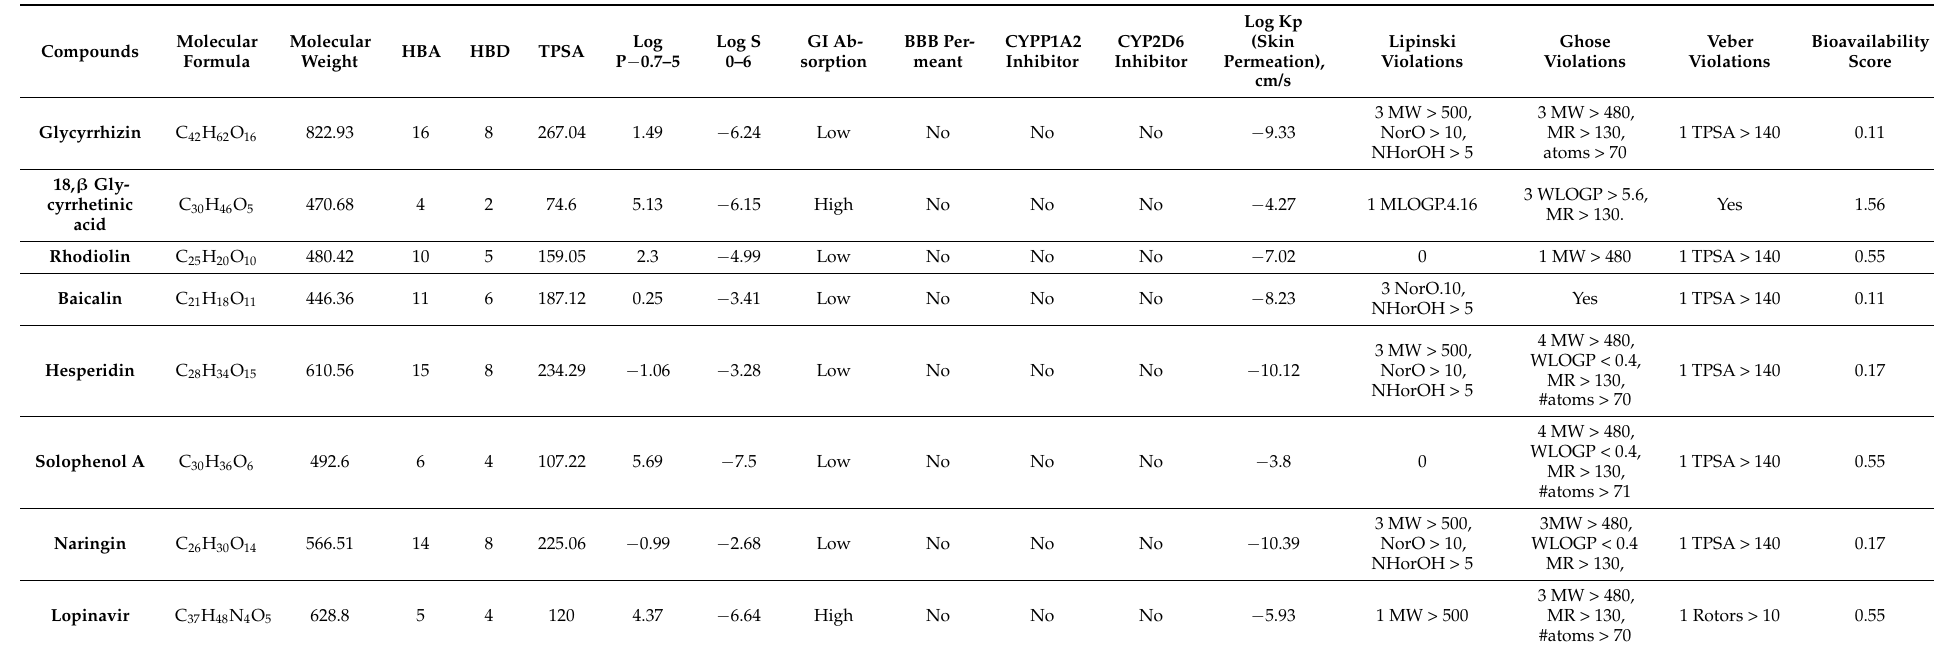
Table 2. ADMET properties of selected